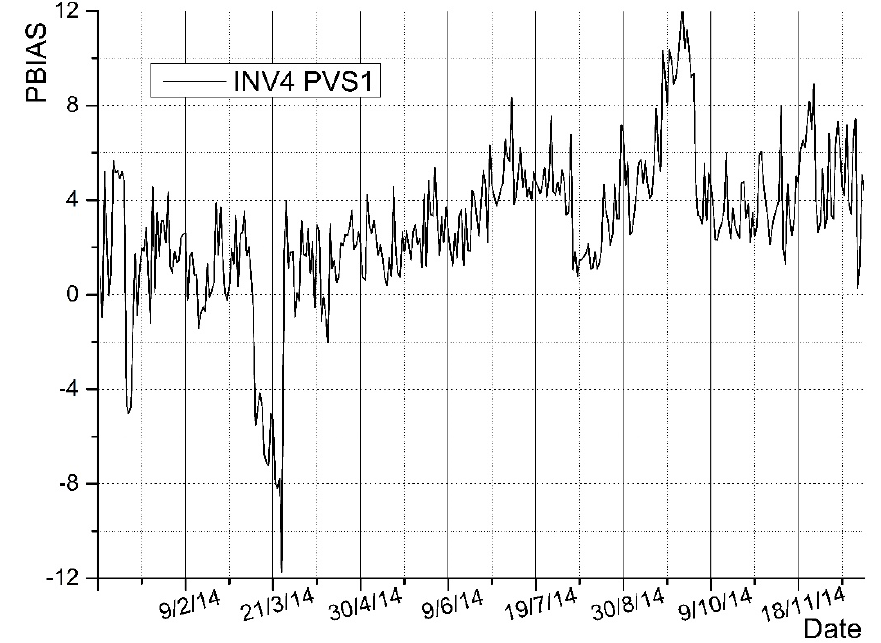
Figure 13. Evolution of percent bias of prediction during the whole year, 2014.